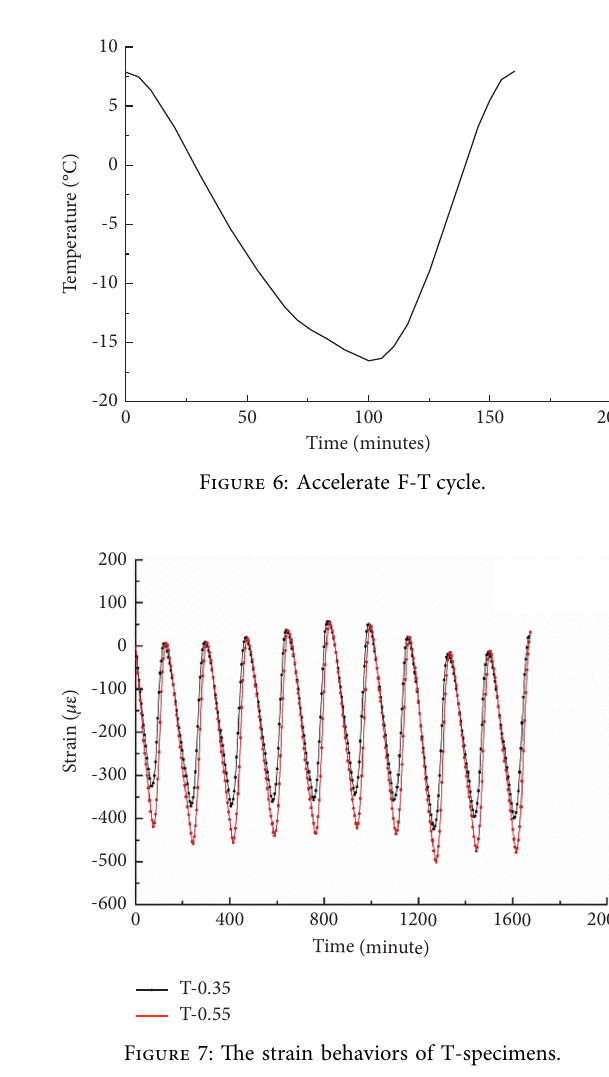
Figure 3: Structural sketch and photo of the testing specimens.